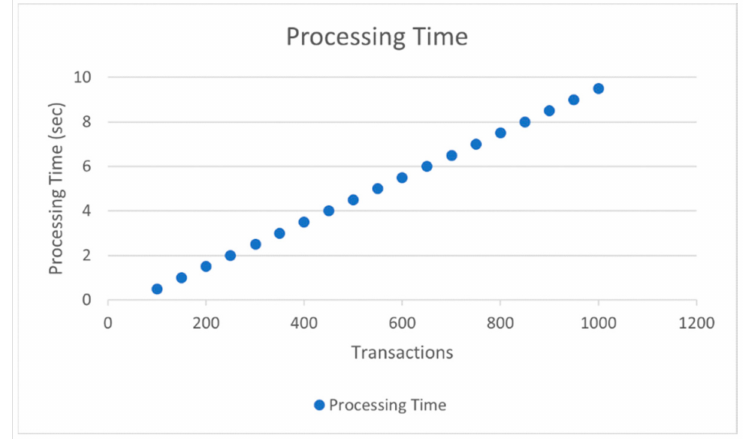
Figure 3. Block preparation timings with regards to the transaction number.